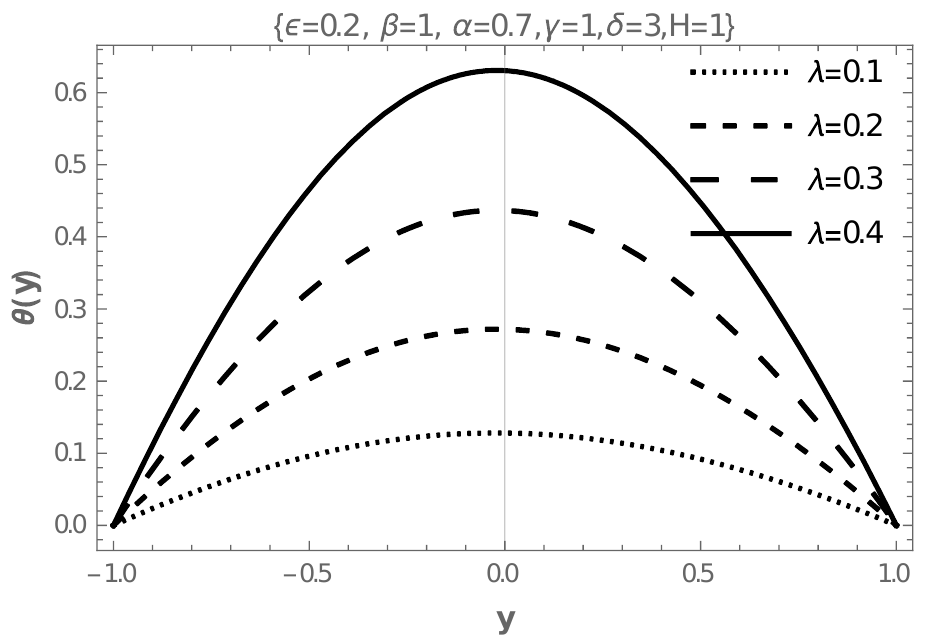
Figure 8. Velocity profile with Frank–Kameneskii parameter ( λ ).